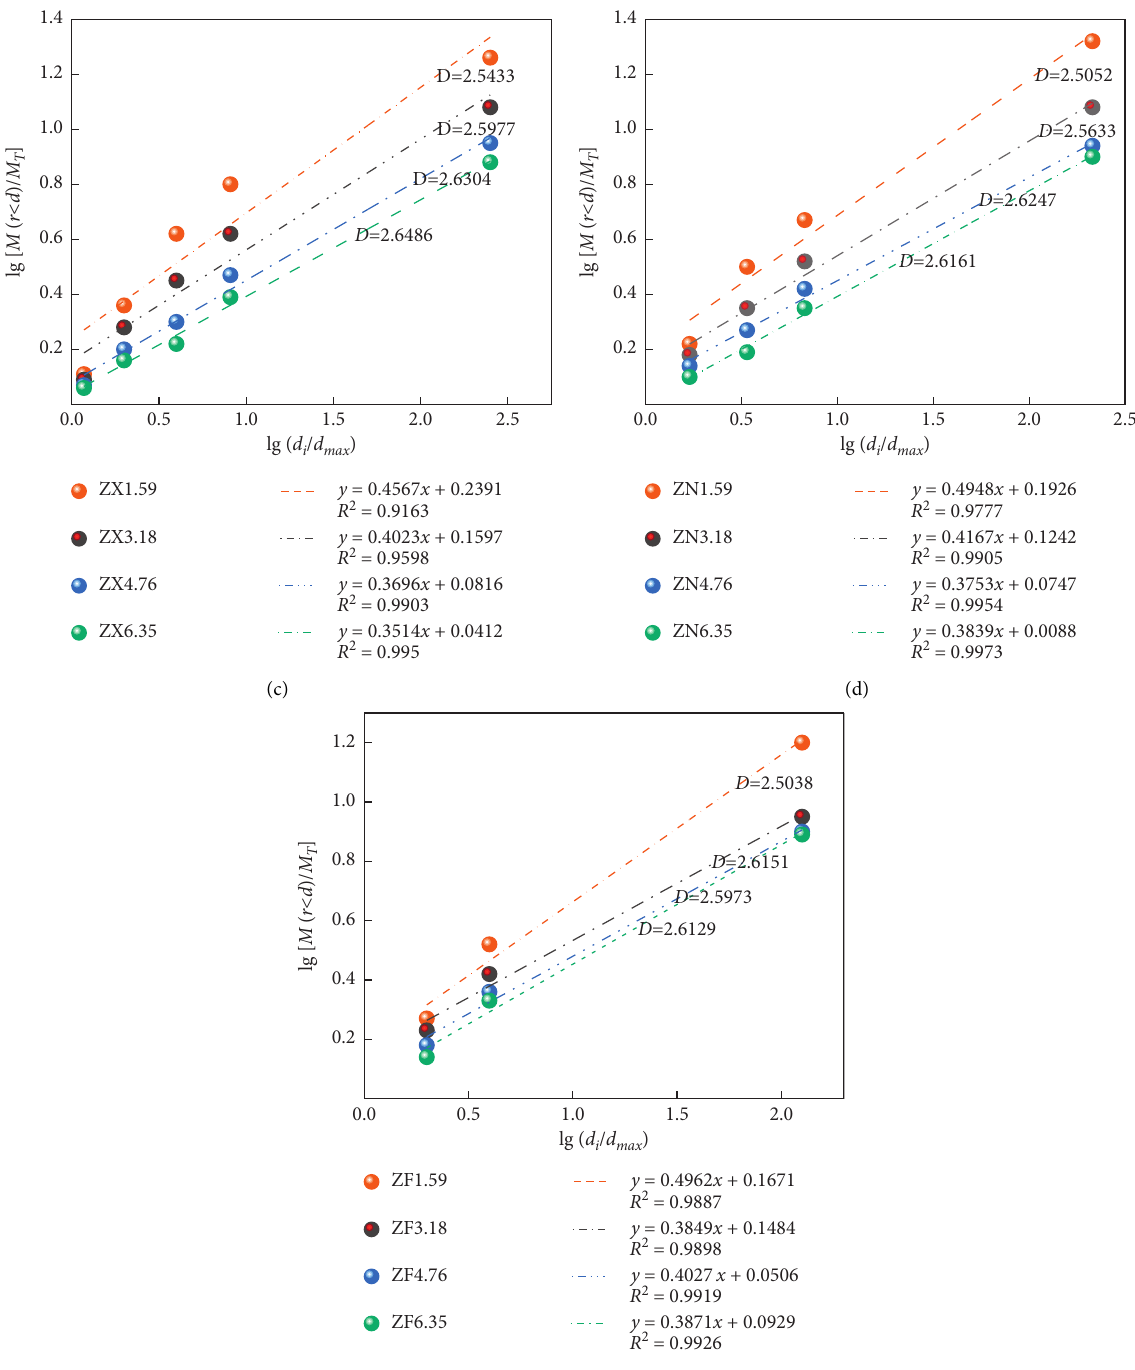
Figure 11: Fractal curve of reclaimed brick size. (a) 26.5–31.5mm. (b) 19–26.5mm. (c) 16–19mm. (d) 9.5–16mm. (e) 4.75–9.5